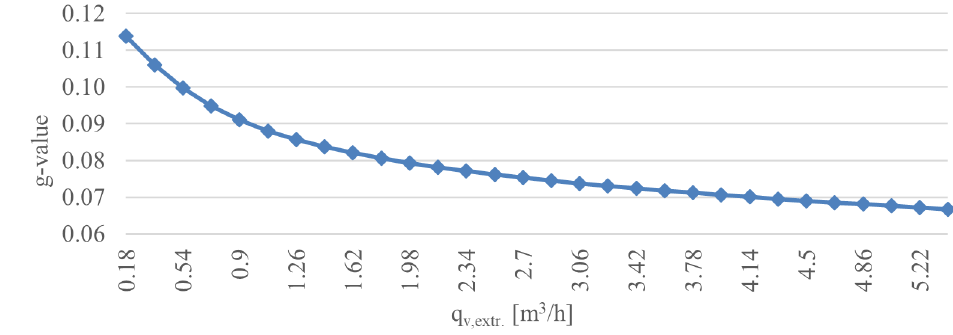
Figure 3. Graphical report of the g-value results with respect to the extraction airflow rate.